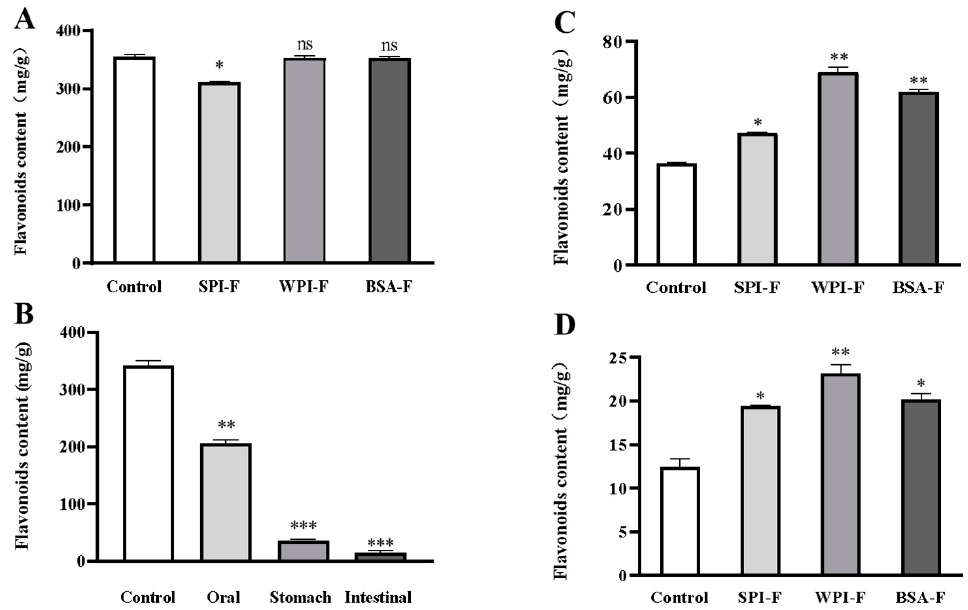
Figure 2. Changes of the flavonoids content after combination with different proteins. ( A ) the flavonoids content of the combined with different proteins; ( B ) the retained flavonoids content after the just the flavonoids being digested by using the simulated oral and gastrointestinal digestive solution; ( C ) the retained flavonoids content in the complex of proteins and flavonoids after being digested with the simulated gastric juice; ( D ) the retained flavonoids content in the complex of proteins and flavonoids after being digested with the simulated intestinal digestion. * p < 0.05, ** p < 0.01 and *** p < 0.001.